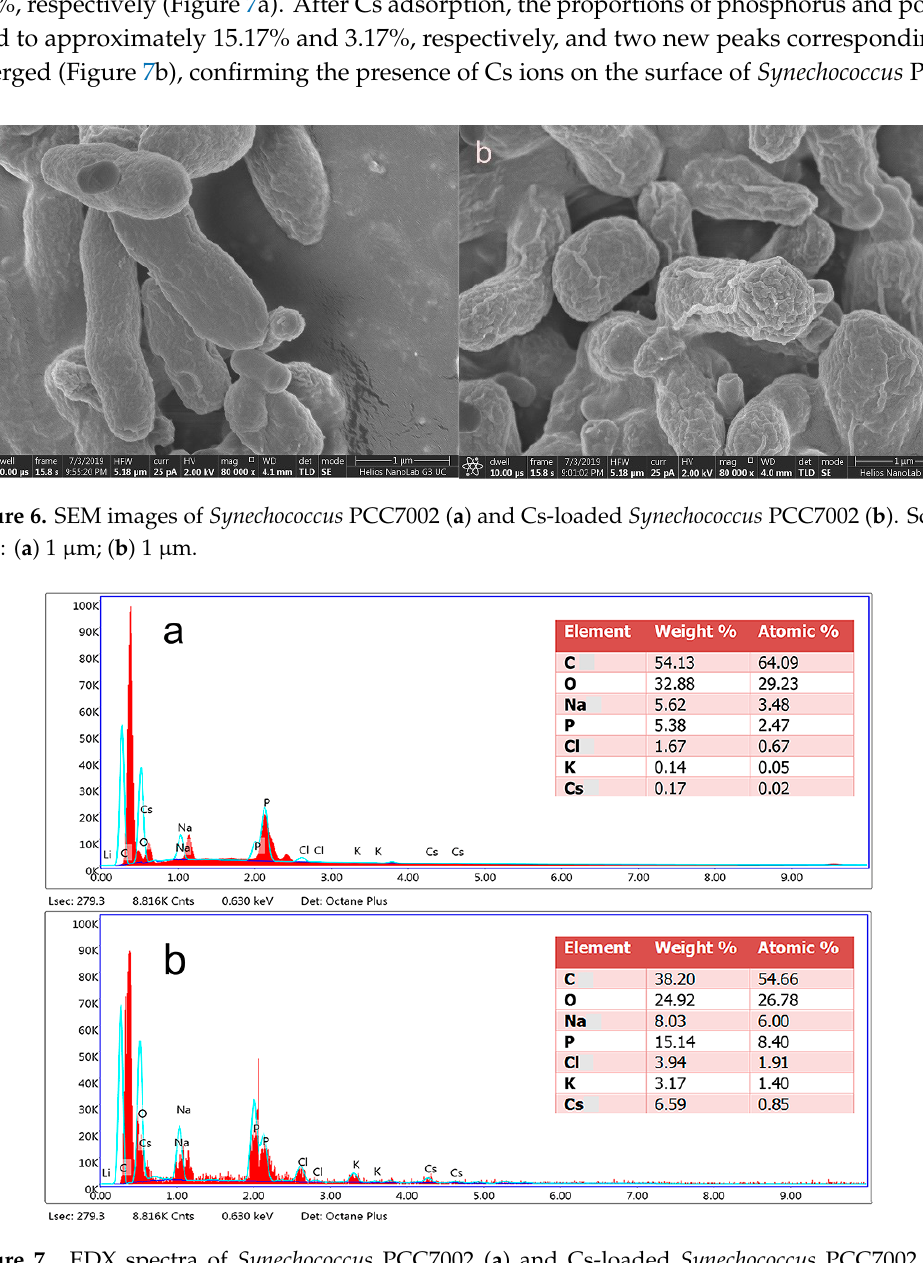
Figure 7. EDX spectra of Synechococcus PCC7002 ( a ) and Cs-loaded Synechococcus PCC7002 ( b ). The elements analyzed were C, O, Cl, P, Na, K, and Cs.